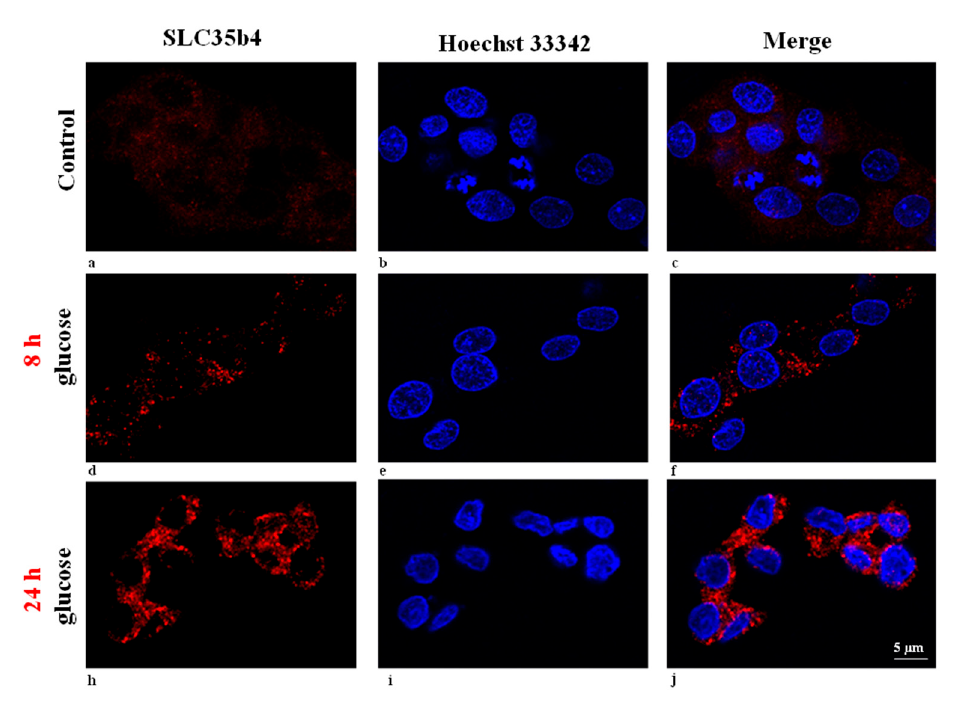
Figure 1. Immunostaining for SLC35B4 in HepG2 cells. Cells were incubated for 8 h or 24 h in the presence of 10 mM glucose. As a control, immunostaining was performed on untreated cells by omitting the primary antibody. Immunostaining was detected using Alexa fluor555. Cell nuclei were counterstained with Hoechst 33342 dye. Scale bar, 5 µ